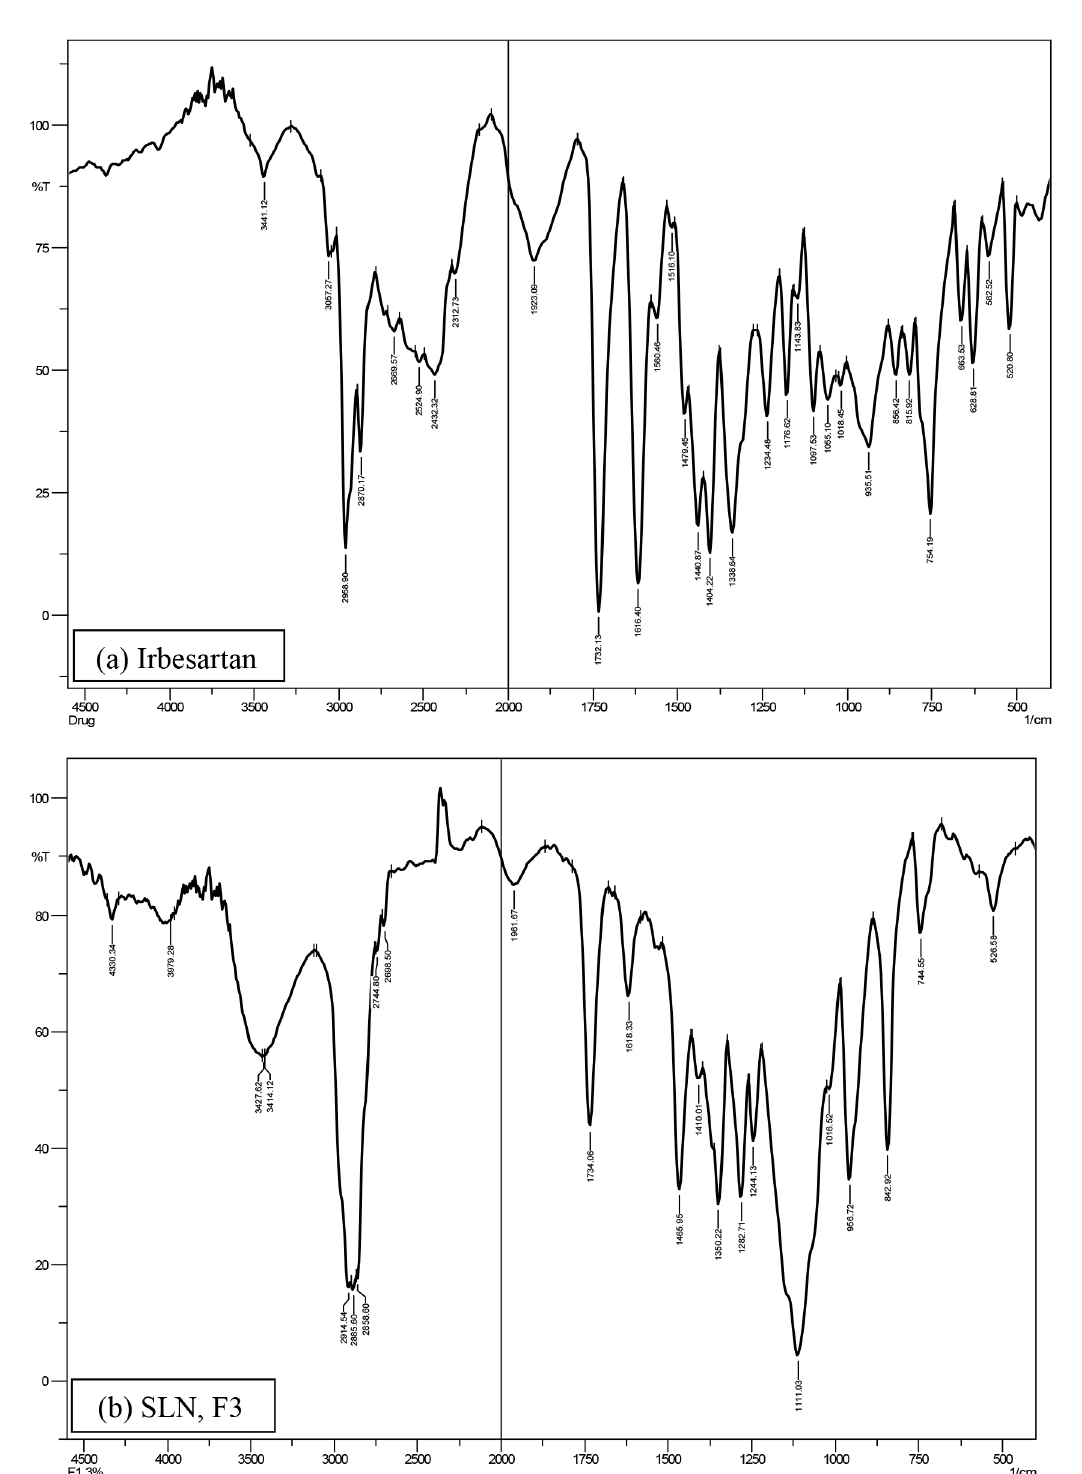
FIGURE 3 - FT-IR spectra of (a) pure drug, Irbesartan and (b) Irbesartan-loaded SLN F3. of irbesartan. Poloxamer 407 was used to improve